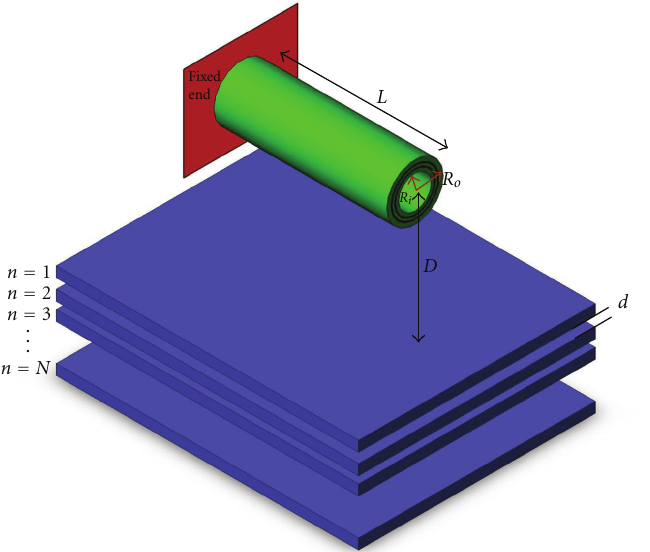
Figure 1: Schematic of an MWCNT suspended over graphite